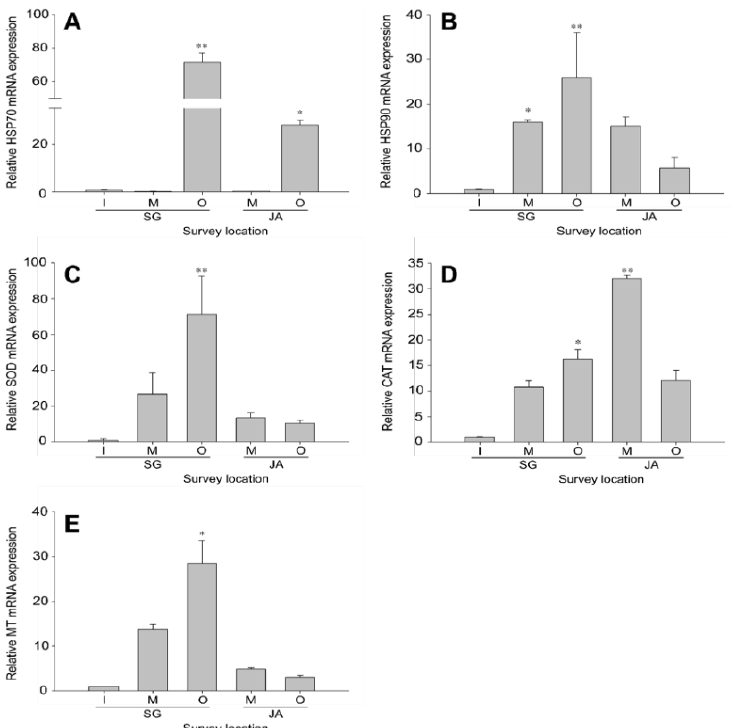
Figure 2. Gene expression analysis of HSP70 ( A ), HSP90 ( B ), SOD ( C ), CAT ( D ), and MT ( E ) in Zacco platypus gills. The data are presented as the mean ± SD. The expression levels of each gene were compared with the expression level in Singal Lake inflow (expression level = 1). Significant differences are indicated with asterisks: * p < 0.05 and ** p < 0.01.